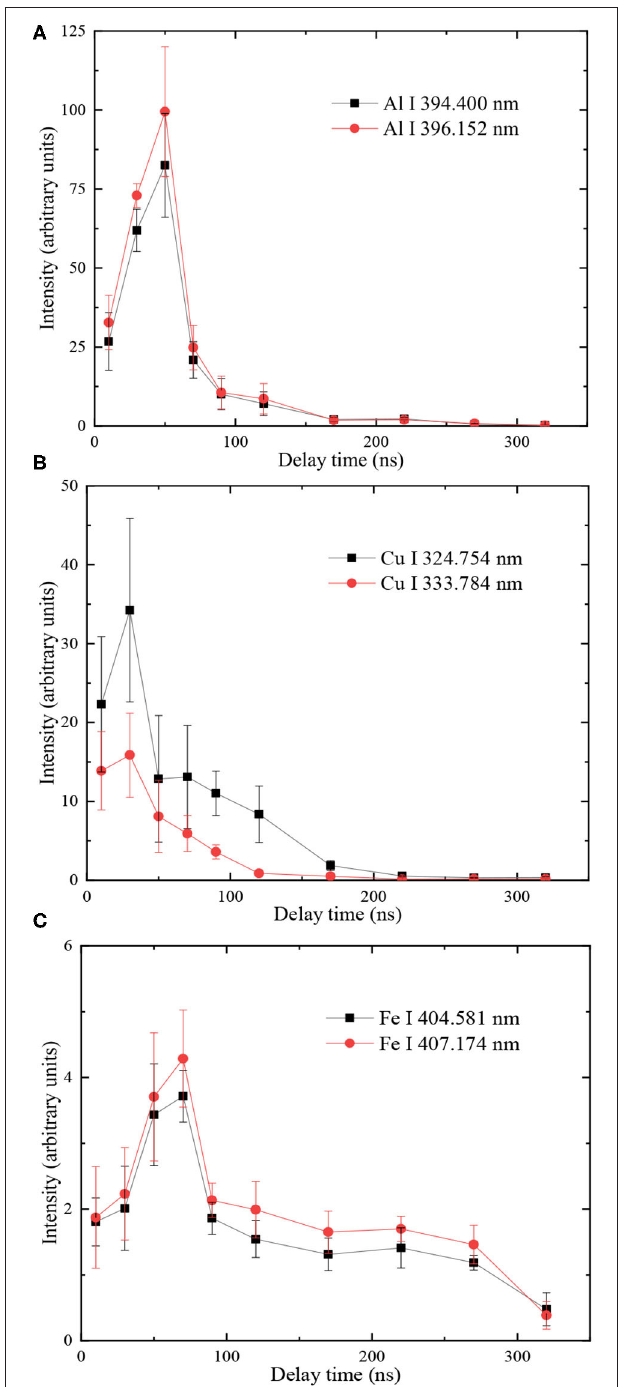
FIGURE 4 | Time-resolved intensity of collinear LS-DP-LIBS. (A) Al sample, (B) Cu sample, and (C) Fe sample. Experimental conditions: gate width: 100 ns, accumulation: 50 shots, repetition of experiments: 5